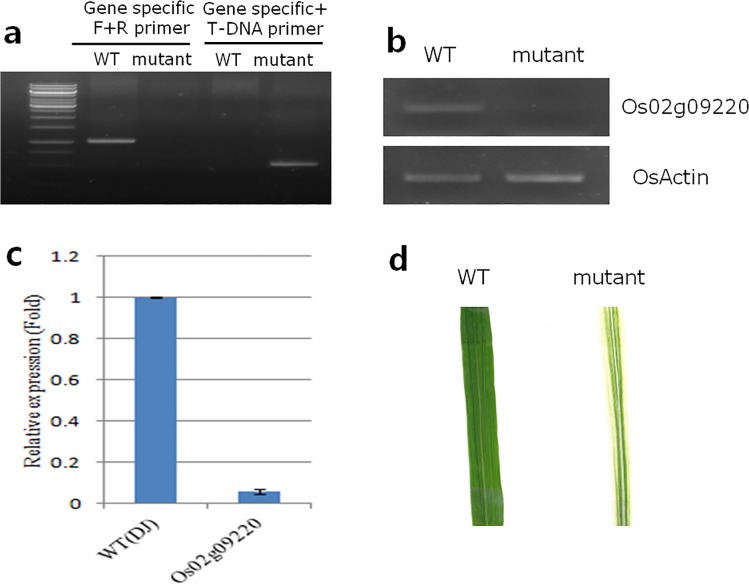
Verification of Os02g09220 affecting leaf color by qPCR, T-DNA insertion, and phenotypic characterization.(a) PCR of genomic DNA showed the successful generation of the T-DNA insertion mutant. (b) RT-PCR revealed the expression of the Os02g09220 gene in the mutant. (c) The qRT–PCR analysis of Os02g09220 expression between the wild-type and T-DNA insertion-mutant plants. (d) Phenotypic comparison of the two plant types.